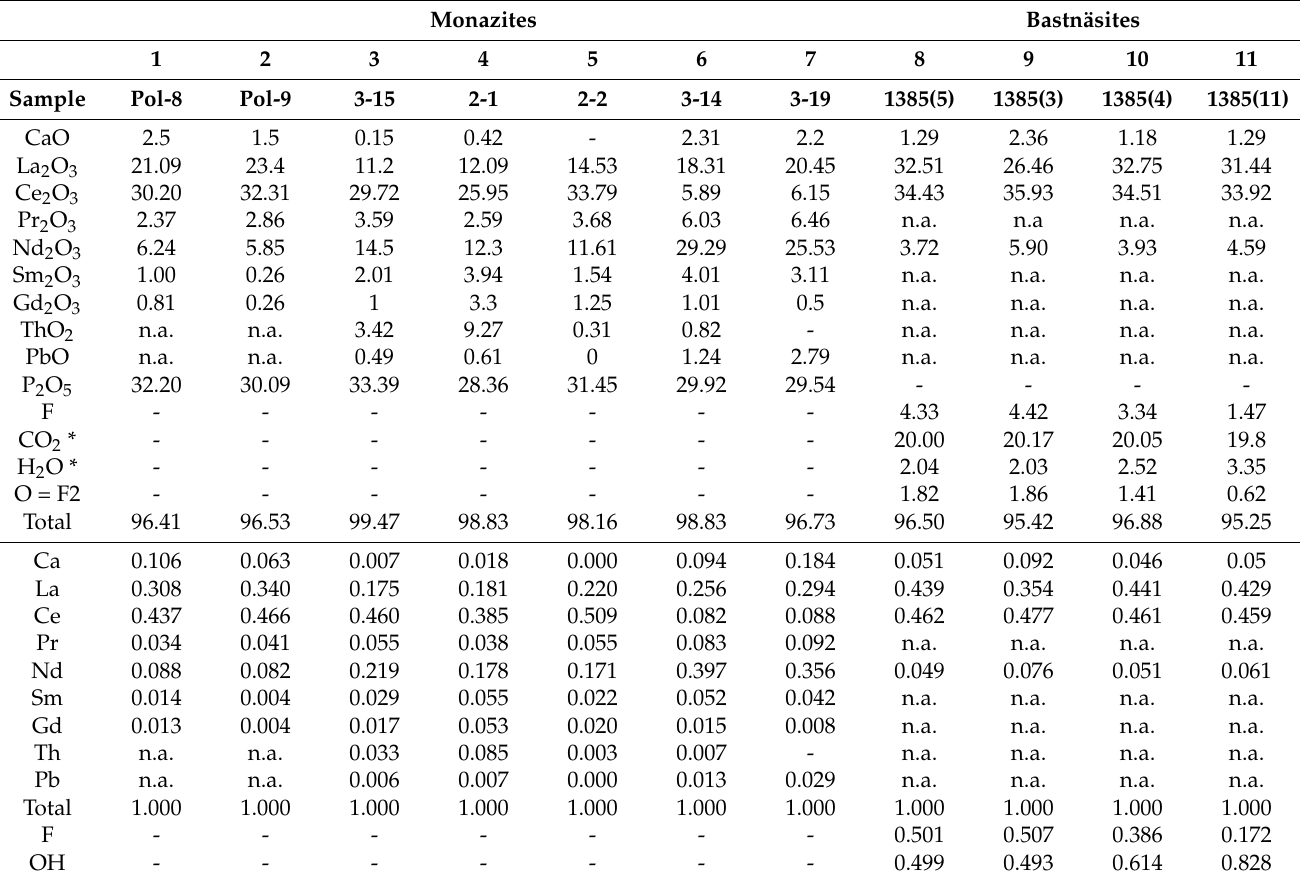
Table 2. Representative compositions (wt%) of monazite and bastnäsite. Monazites